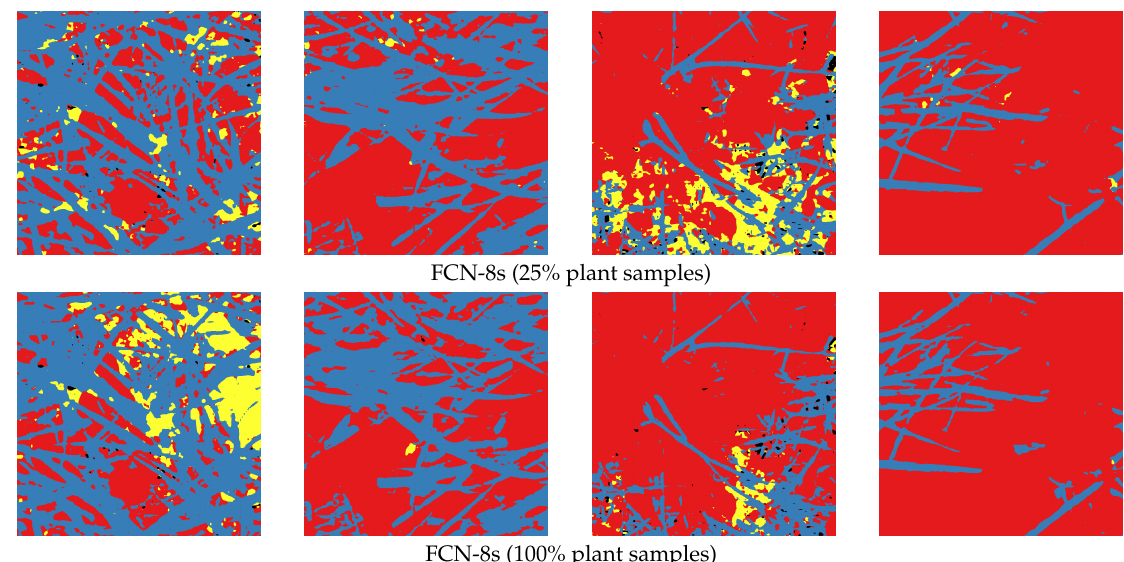
Comparison between four ground truth labels of the hand-annotated images, our implementation of the approach by Bonesmo et al. [11], and the two instances of convolutional neural network (CNN)-driven segmentation. The areas in blue represent grass, those in red represent clover, those in yellow represent weeds, those in black represent soil, and those in white represent areas that could not be distinguished in the manual